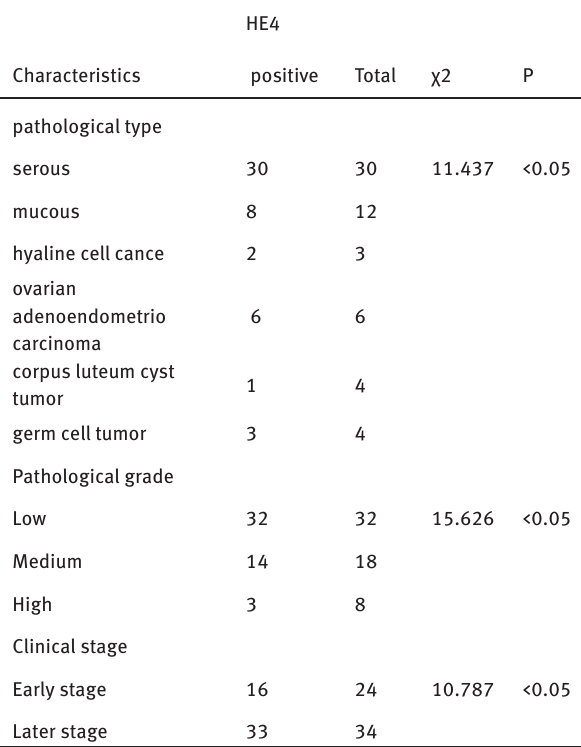
Table 3: Relationship between HE4 in tissue and pathological type, grading and clinical staging in group of malignant ovarian tumor